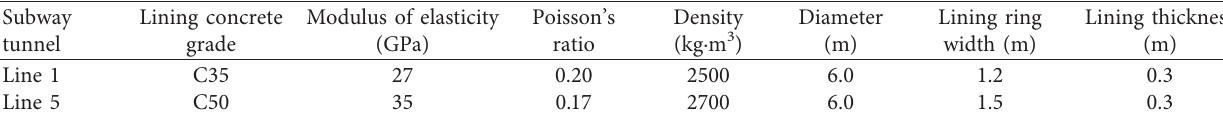
Figure 2: Calculation model. Table 2: Shield segment parameters.